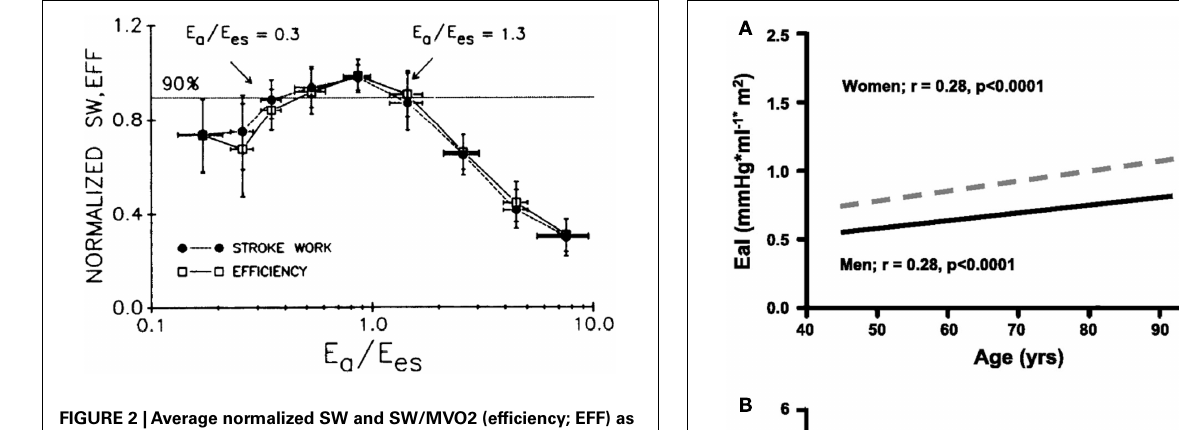
FIGURE 2 |Average normalized SW and SW/MVO2 (efficiency; EFF) as a function of arterial–ventricular coupling ratio. Both parameters reach optimal values between E A /E es (E es = E LV ) ratios spanning 0.3–1.3. From De Tombe et al. (1993) with permission.